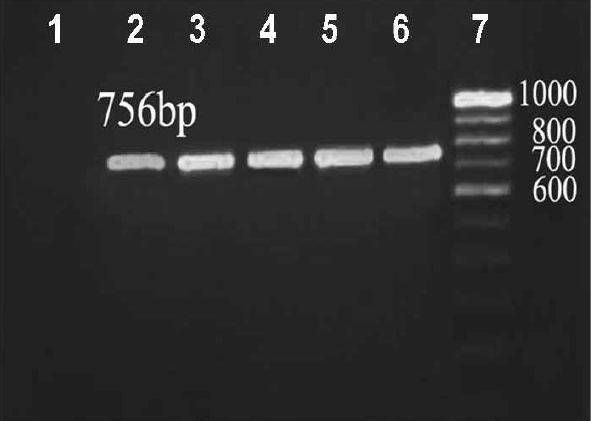
Figure-3: Screening of field isolates for detection of staphylococci using Genus specific 16S rRNA binding primer. Lane 1: Negative isolate, Lane 2 to 6: Positive isolates, Lane 7: DNA ladder.